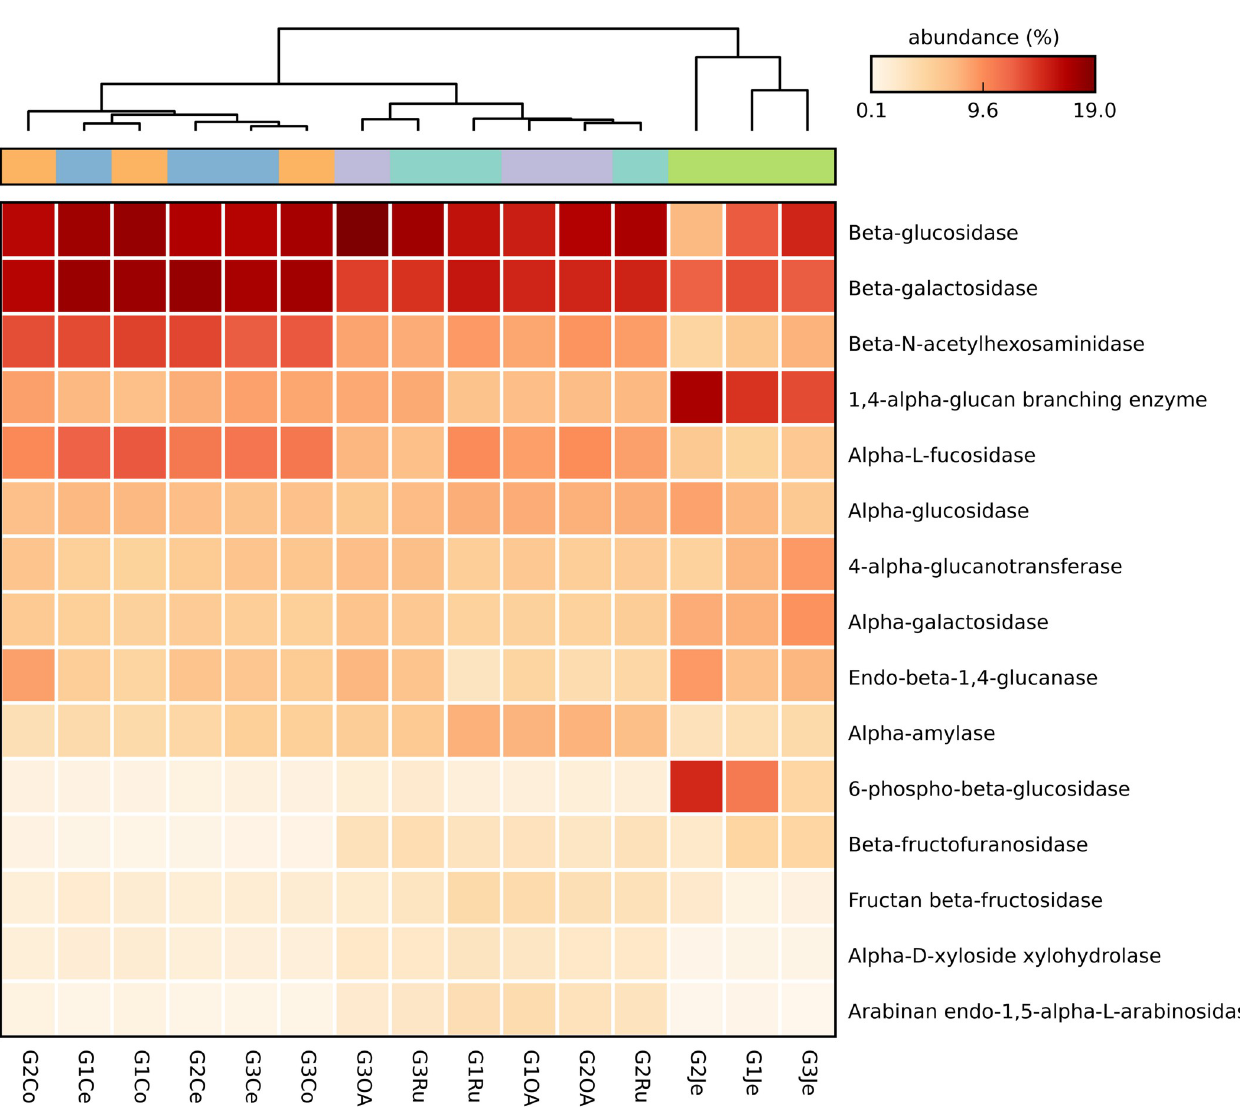
Fig 4. Heatmap of the 15 most abundant bacterial GHs predicted genes participating in carbon metabolism across the Capra hircus GITs. The heatmap was constructed with the relative abundances of the functional Level 4 KEGG pathways. Ru, rumen; OA, omasum + abomasum; Je, jejunum; Ce, cecum; Co,